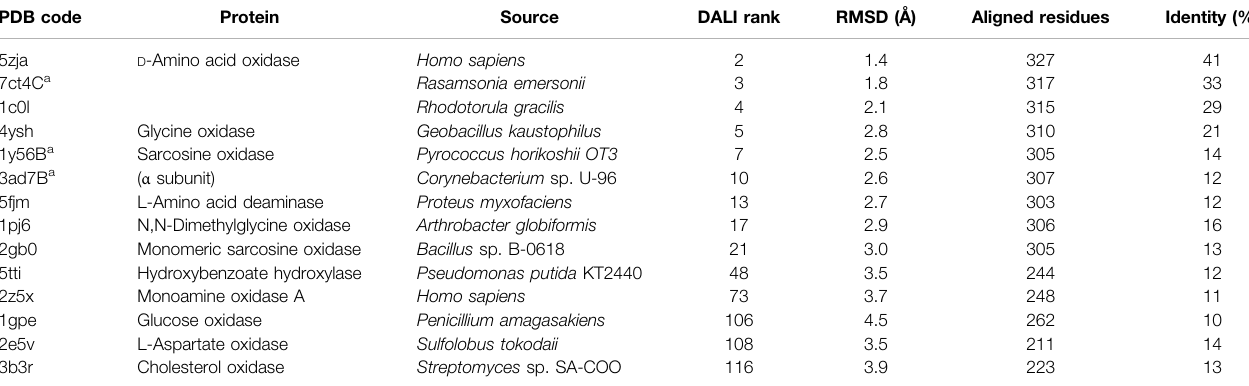
a The last letter identi fi es the chain of the corresponding 3D structure.